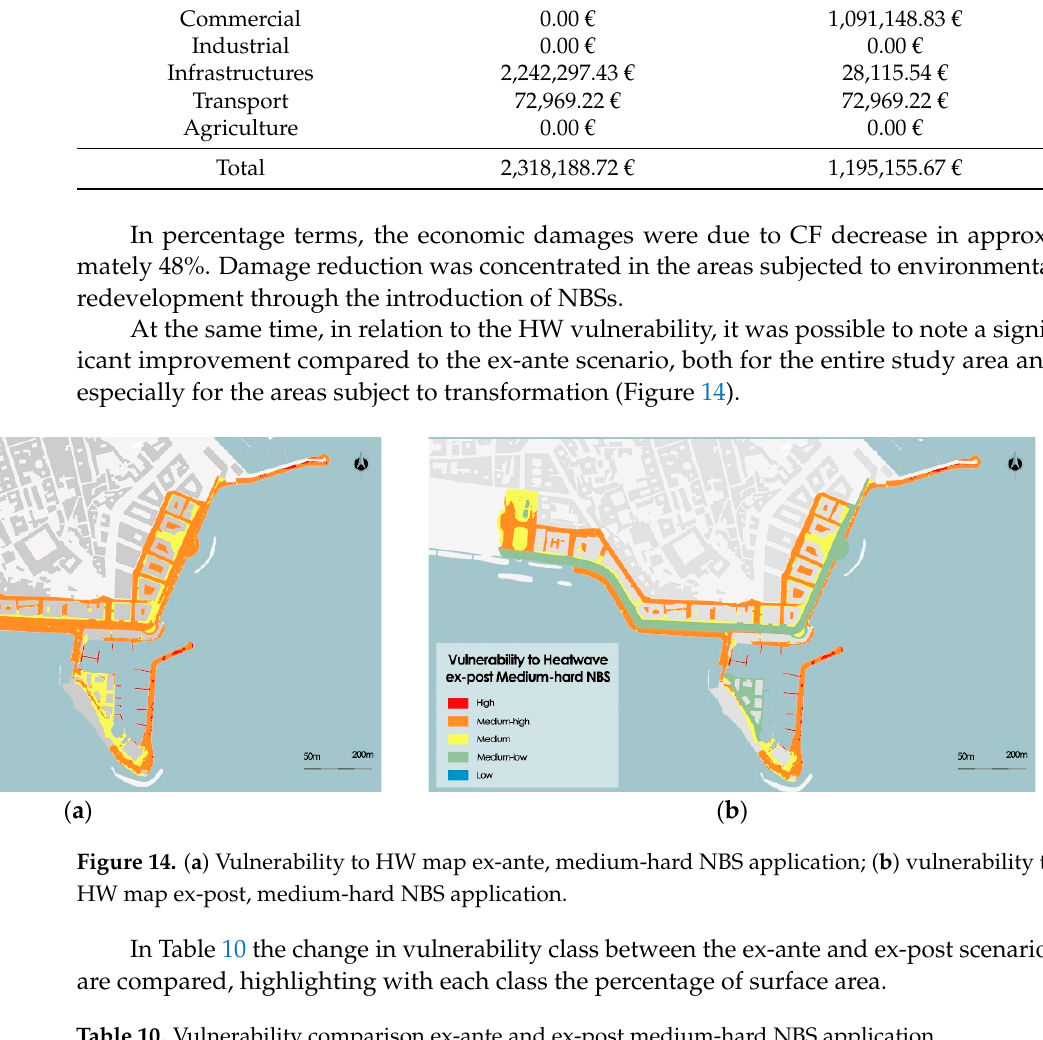
Table 10. Vulnerability comparison ex-ante and ex-post medium-hard NBS application.